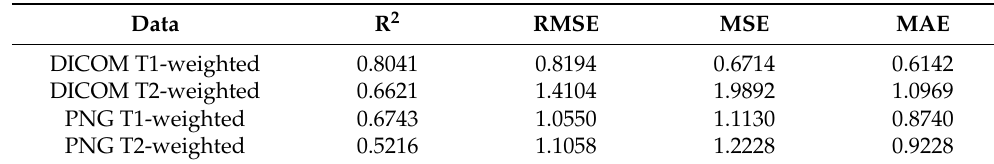
Table 3. Quantitative regression parameters for different types of data and growth region images (metric). Results for 3 features derived from 15 by applying principal component analysis.